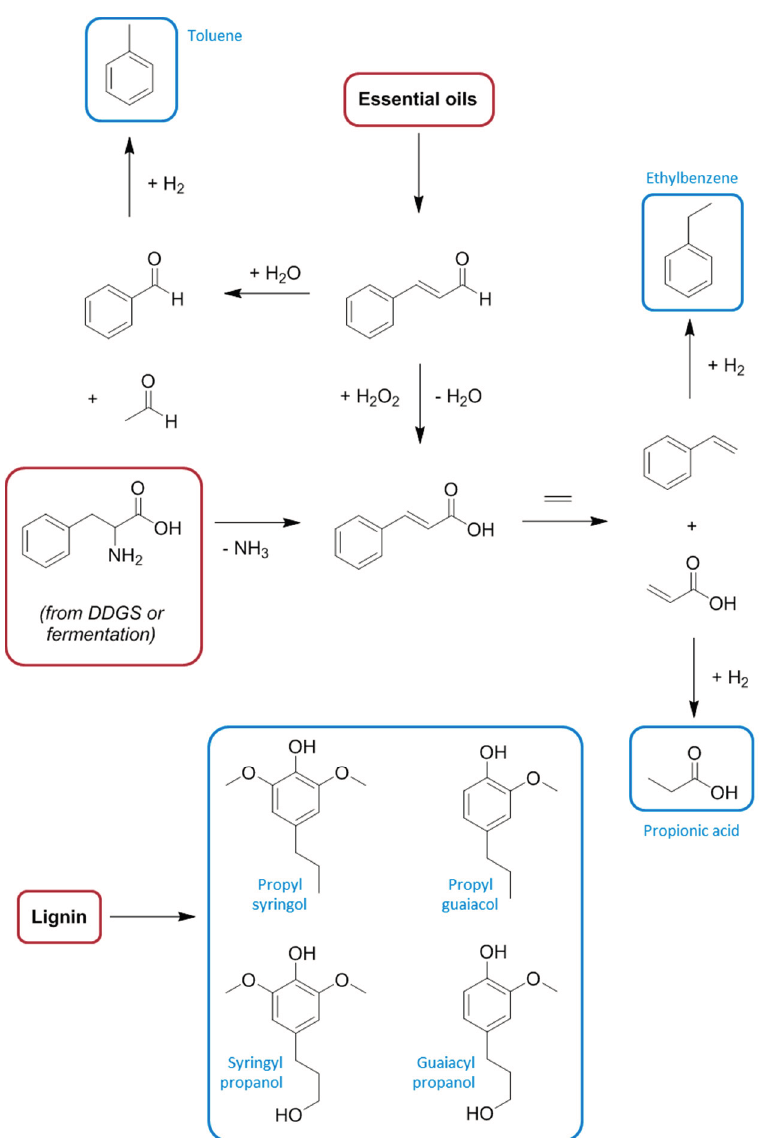
Scheme 10. Possible methods for the synthesis of some bio-based aromatic solvents. Key: red = feedstocks, blue =